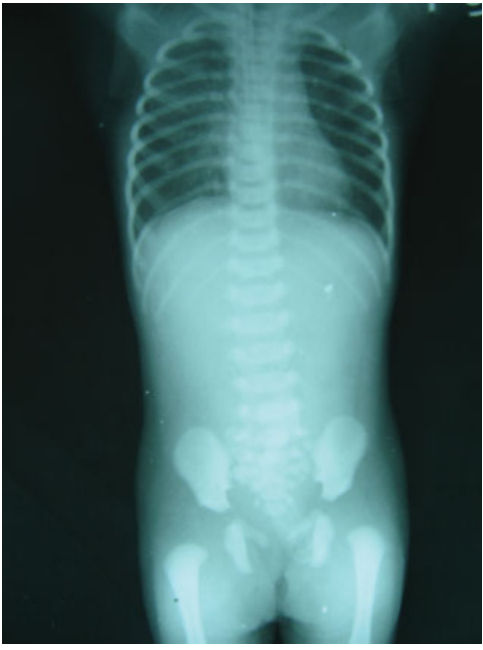
Fig. 1 Chest X-ray showing upper pouch ending at T 8 . Also note the absence of gas in the abdomen and pelvis.